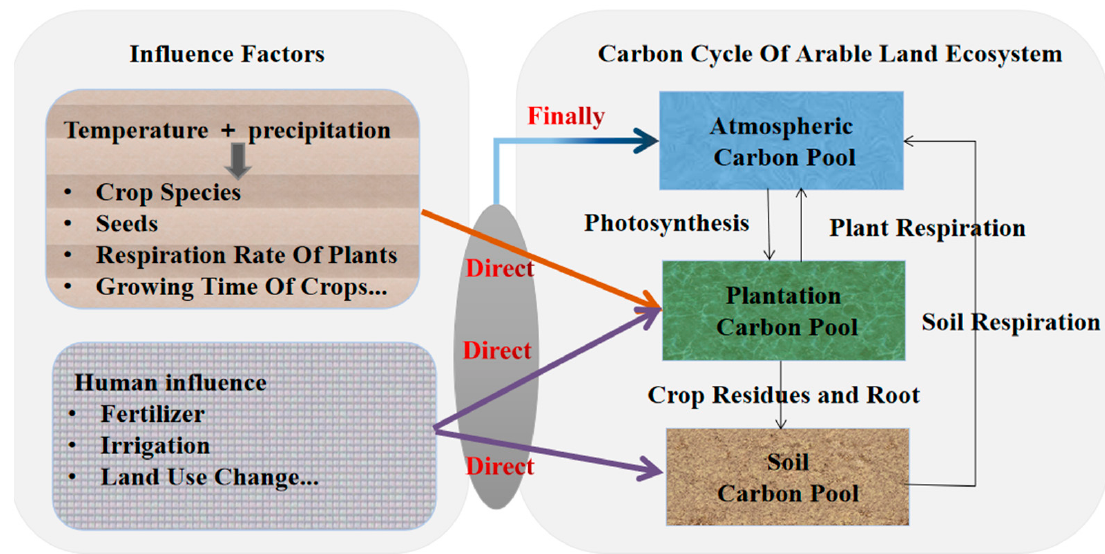
Figure 2. The diagram depicts the flow of carbon between the soil carbon pool, the atmospheric carbon pool and the plantation carbon pool in arable land ecosystems.